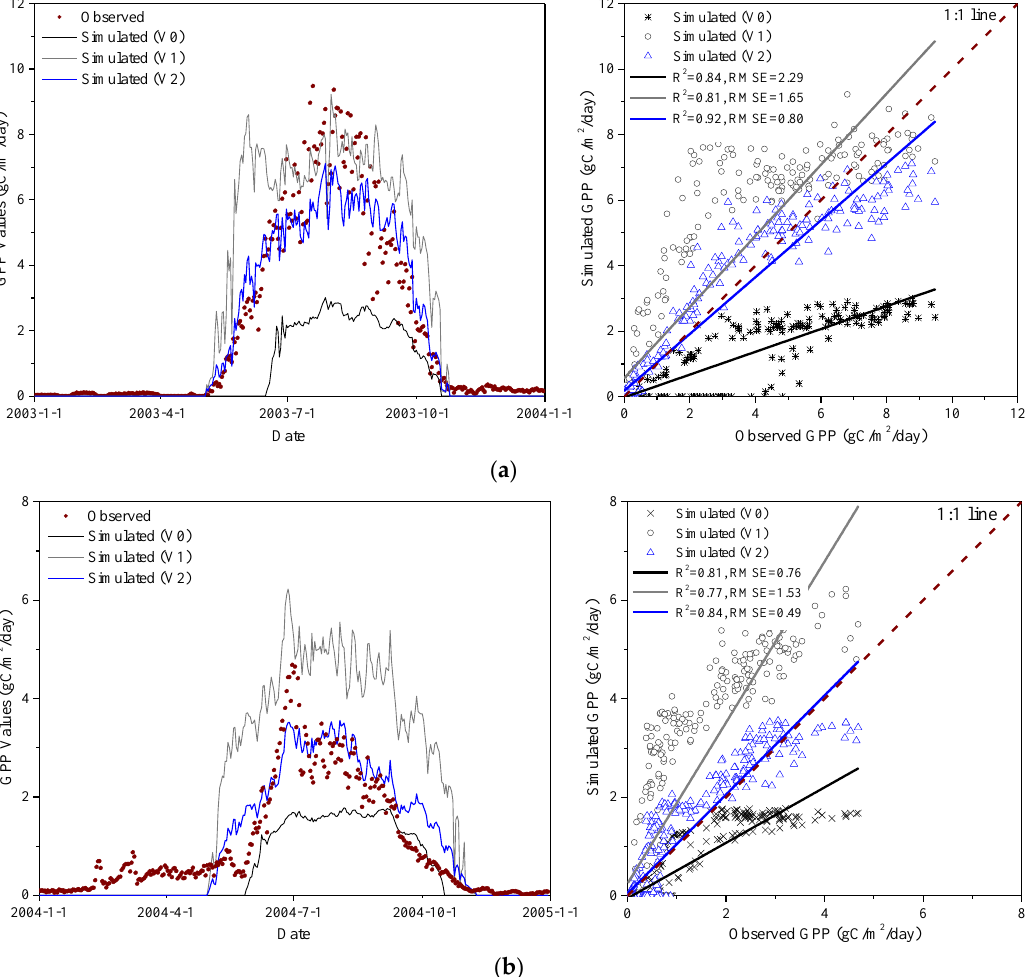
Figure 4. Comparisons between GPP derived from EC measurements and GPP simulated by the version of V0, V1, and V2 for the calibration year. ( a ) Haibei Station (alpine meadow); ( b ) Damxung Station (alpine steppe).